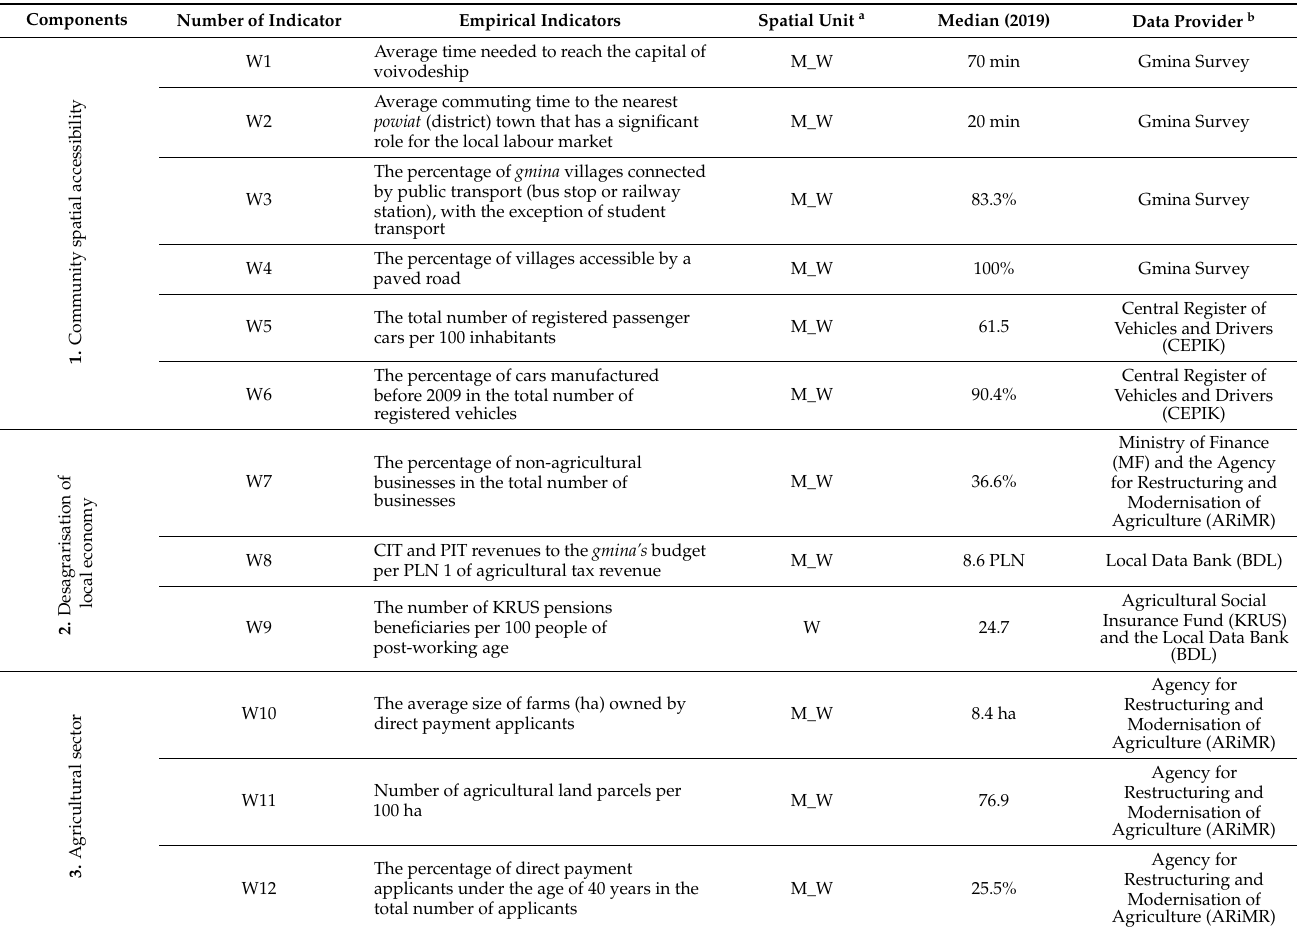
Table A1. List of Empirical Indicators Used in the Rural Development Monitoring